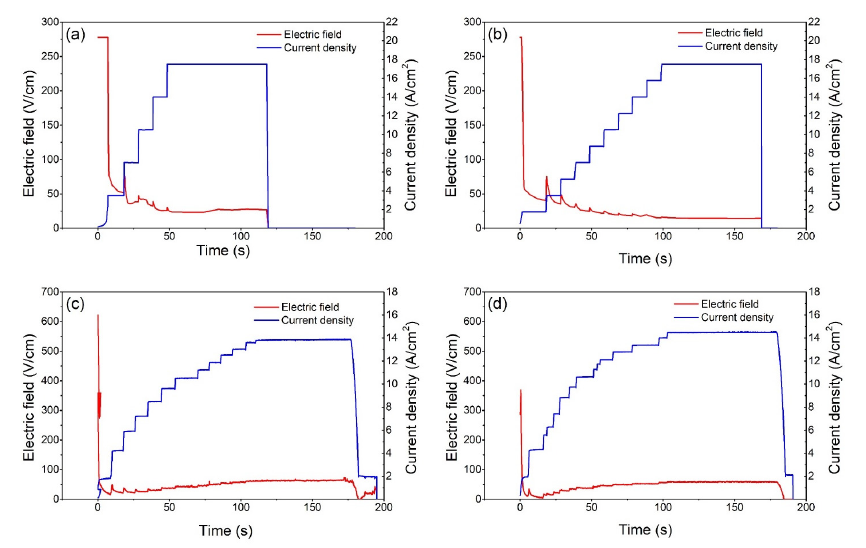
Figure 1. Electric field and current density change during ( a ) 0.1Li DC, ( b ) 0.3Li DC, ( c ) 0.1Li AC, and ( d ) 0.3Li AC flash sintering.